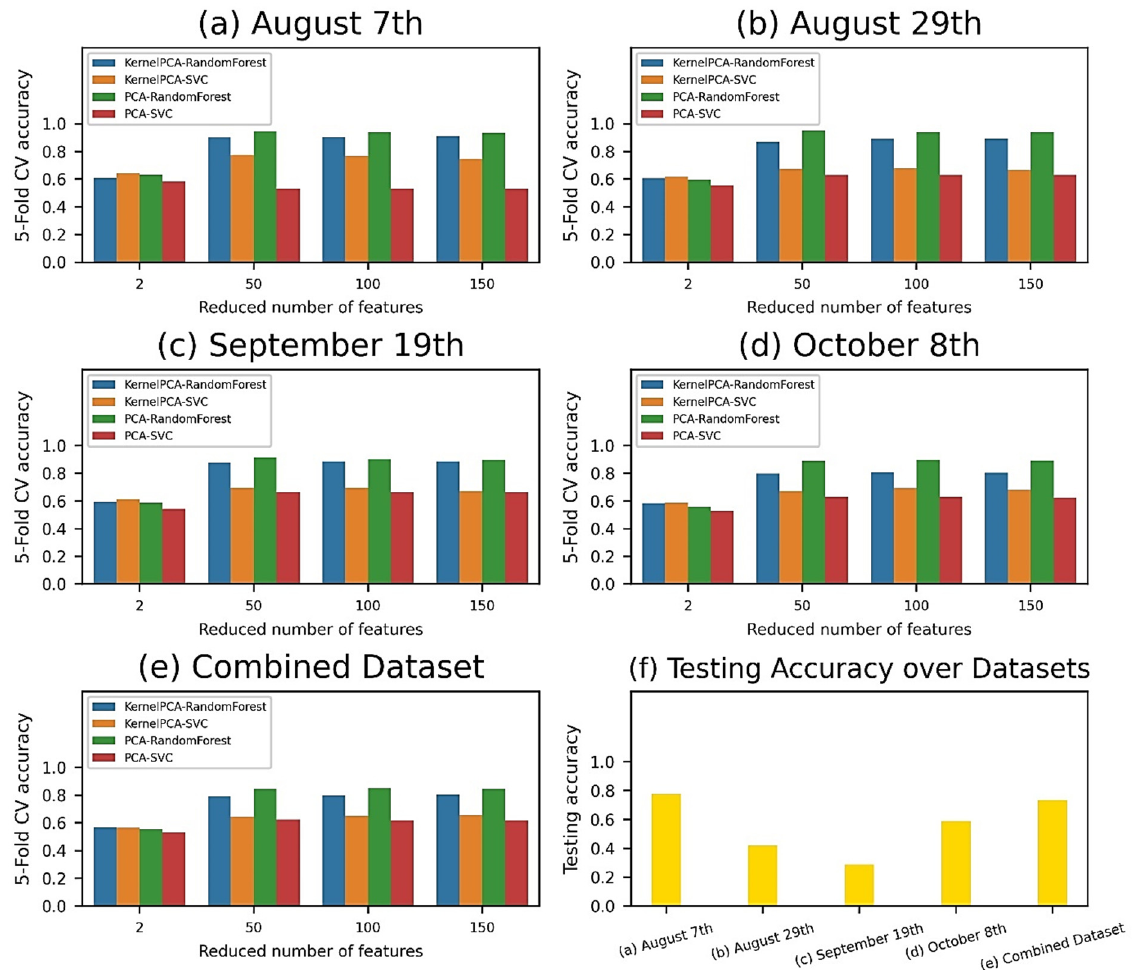
Figure 8. Pixel-wise classification performance for different machine learning pipelines and datasets. The 5-fold cross validation (CV) accuracy was plotted by reducing the number of features for the August 7th ( a ), August 29th ( b ), September 19th ( c ), October 8th ( d ), and combined dataset ( e ). The best pipelines were the PCA–random forest pipeline with the 50-feature model (94.70%) for August 7th data, the PCA–random forest pipeline with the 50-feature model (95.30%) for August 29th data, the PCA–random forest pipeline with the 100-feature model (91.60%) for September 19th data, the PCA–random forest pipeline with the 100-feature model (89.70%) for October 8th data, and the PCA–random forest pipeline with the 100-feature model (85.10%) for the combined dataset. These pipelines were selected for evaluation on the test set ( f ).